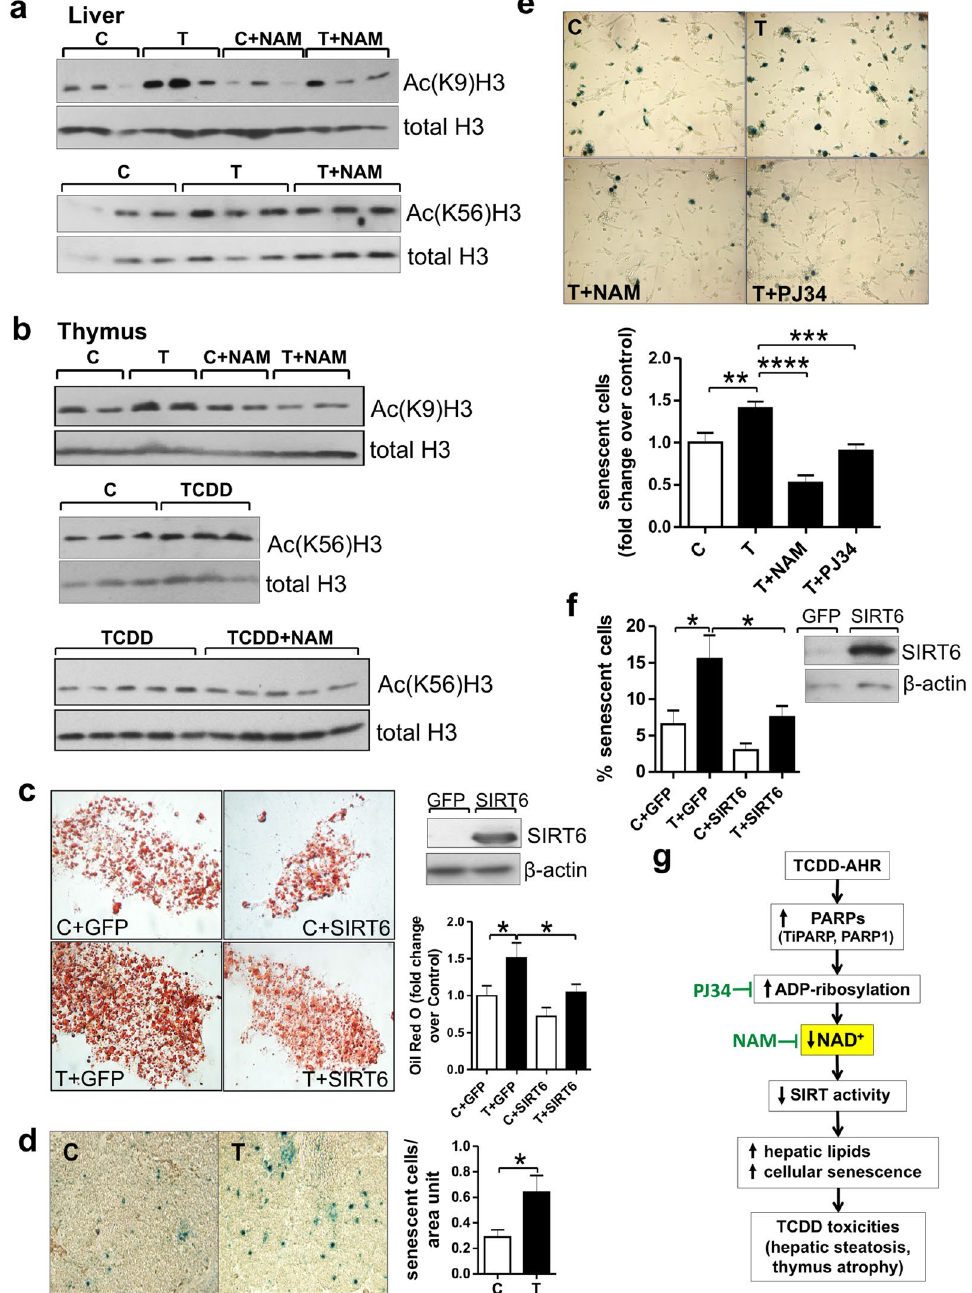
Figure 4. NAD + loss by TCDD decreases Sirt6 activity. Role for Sirt6 in TCDD toxic effects. ( a ) Western blots on homogenates of liver and thymus from CE treated with TCDD or vehicle (n = 3 independent experiments) for 24 hr. CE were cotreated with class I/II deacetylase inhibitors as described in Methods, to allow H3K9 and H3K56 acetylation to serve as indices of Sirt6 deacetylase activity. ( b ) Western blots on homogenates of liver and thymus from CE treated with TCDD (24 hr) with or without NAM for the last 4 hr. ( c ) Representative images of Oil red O stained CEH transfected with an empty plasmid (GFP) or a plasmid containing chick Sirt6 and treated with TCDD (T) or solvent (C). Upper right panel: Western blot on transfected CEH homogenates. ( d ) Representative images for SA-Xgal stained sections of thymus glands from CE treated with TCDD or vehicle for 48 hr. Bar graph shows means ± SE for numbers of senescent cells (blue stained) per unit area of thymus. ( e ) SA-Xgal stained thymic epithelial cells from CE treated with TCDD for 48 hr with or without NAM or PJ34, each injected right after TCDD treatment and 24 hr later. Bar graph shows the mean incidence of senescent cells ± SE per treatment group. ( f ) Means ± SE for incidence of senescent (SA-Xgal stained) thymic epithelial cells transfected with pcDNA-GFP or pcDNA-Sirt6 and treated for 48 hr with TCDD or vehicle. Right panel: Western blot on homogenates of thymic epithelial cells transfected with GFP or Sirt6 plasmids. ( g ) Scheme showing the proposed mechanism by which increased PARP activity produces NAD + loss leading to diverse toxic effects of dioxin in vivo